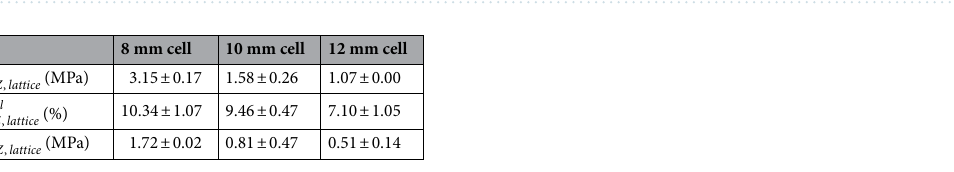
Table 4. Strength, plastic strain, and elastic modulus of 2 × 2 × 1 cell lattice structures for Z- axis loading.